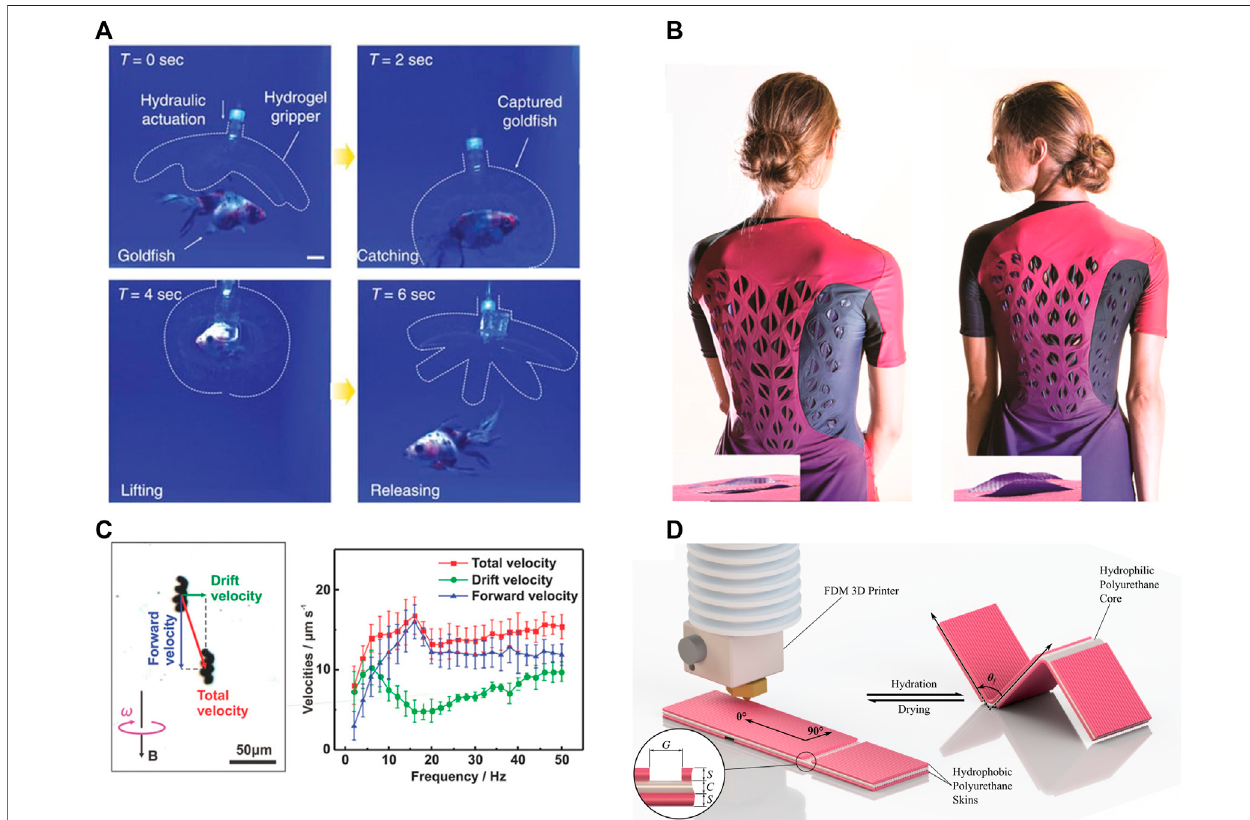
FIGURE 2 | Examples of various applications of hydrogel actuators whose fabrication involves 3D printing. (A) A hydrogel gripper catches, lifts and releases a live gold fi shwithoutharm.Dottedlinesindicatestheboundariesoftransparenthydrogelstructure.Adaptedfrom(Yuketal.,2017)©2017TheAuthorsundertheCC-BY4.0 license. (B) Garment prototype with sweat activated cooling ventilation showing fl at ventilation fl aps before exercise (left) and curved ventilation fl aps after exercise (right) .Adapted from(Wangetal.,2017)©2017TheAuthorsundertheCC-BY 4.0license. (C) Ahydrogelhelicalmicroswimmeractuatedbymagnetic fi eld (left) . Swimming velocities of the microswimmers at different rotational frequency at an applied magnetic rotating fi eld of 8 mT. Adapted from (Wang et al., 2018) ©2018 John Wiley and Sons, Inc. (D) 3D printed tri-layer actuator as modularized origami structure consist of hydrophobic polyurethane top and bottom skins (pink), with a hydrophilic polyurethane core (white) (left) . Itshowshydration-dependent bendingat skin gaps (right) . Adapted from (Baker etal.,2019) ©2019The Authorsunder the CC-BY 4.0 license. All fi gures are used with permission.